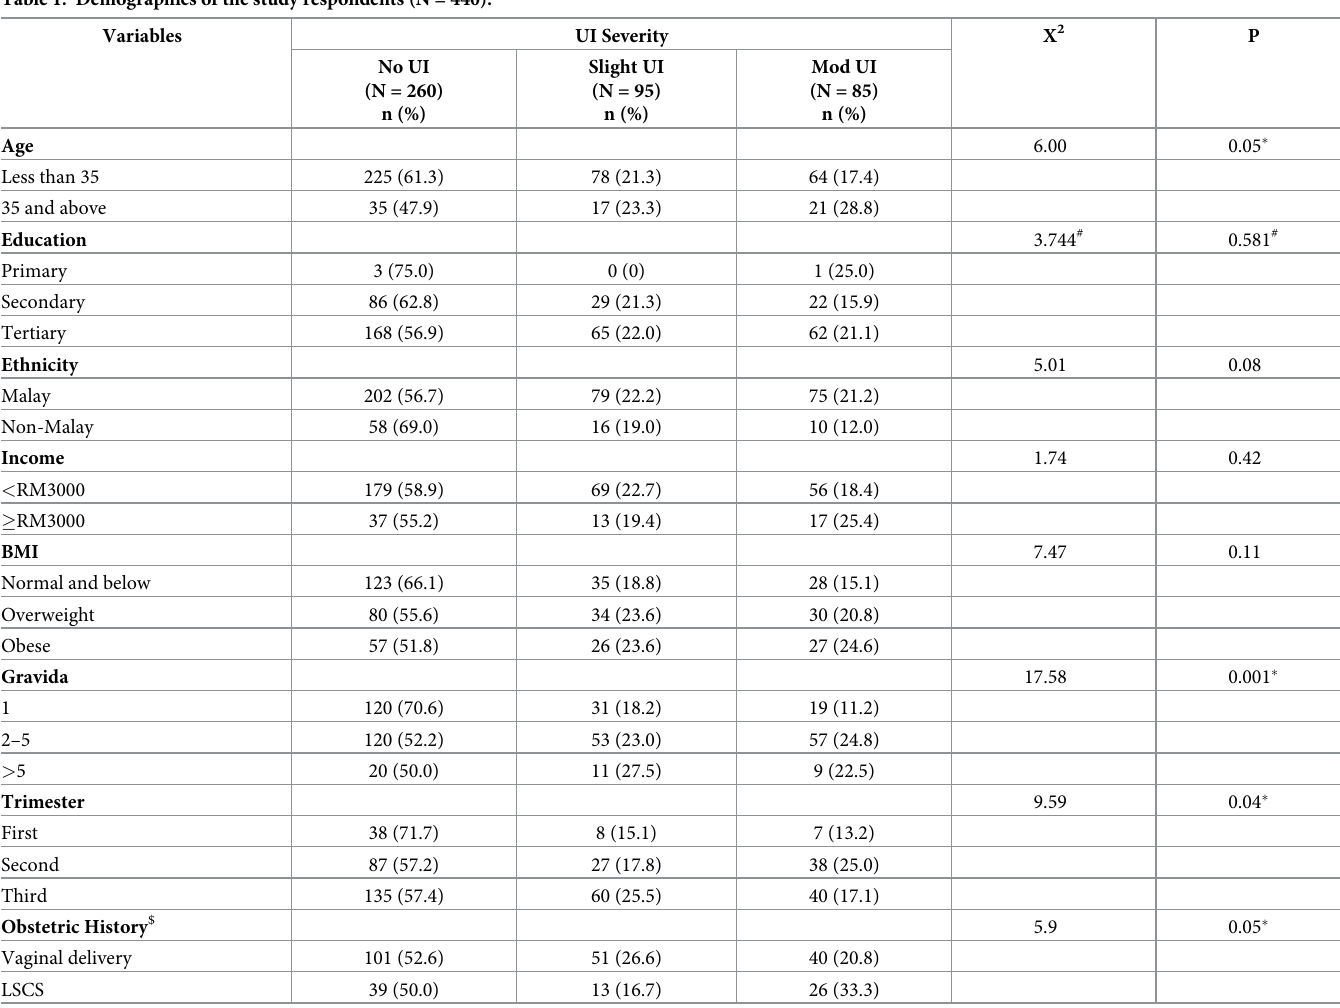
Table 1. Demographics of the study respondents (N = 440).